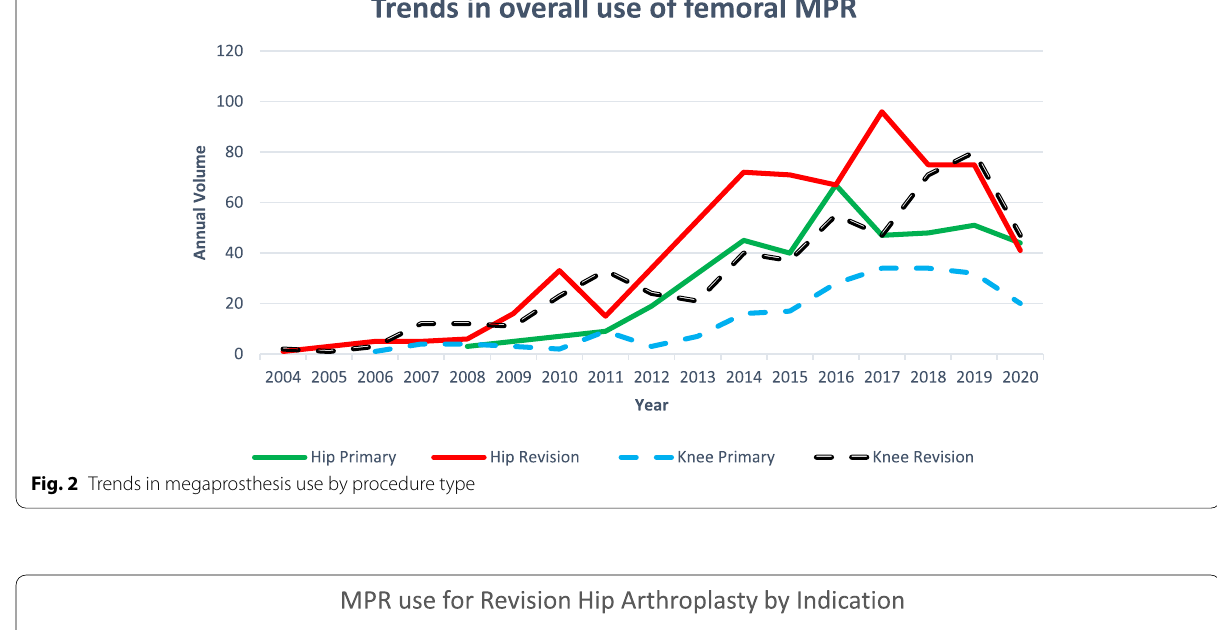
Fig. 2 Trends in megaprosthesis use by procedure type